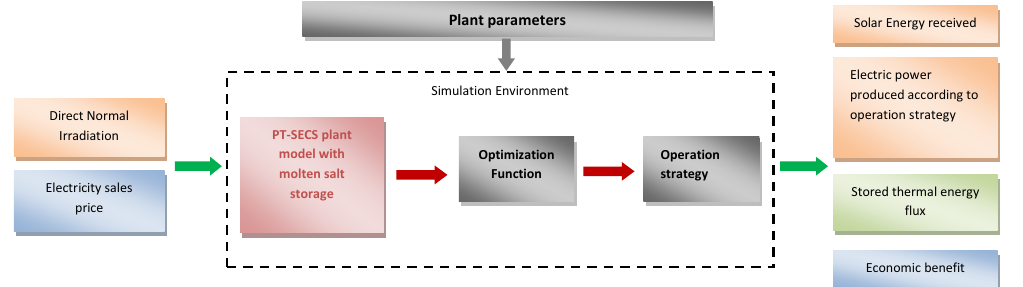
Figure 3. Simulation environment and data flow [26].